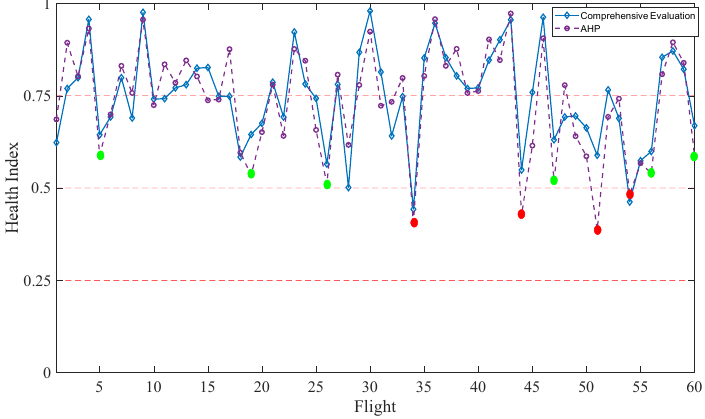
Figure 13. Comparison of AHP and comprehensive assessment.